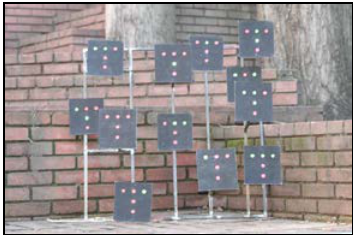
Figure. 4. Image with 70 mm autofocus focal length. The targets of Iwitness software mounted on a layered metal base